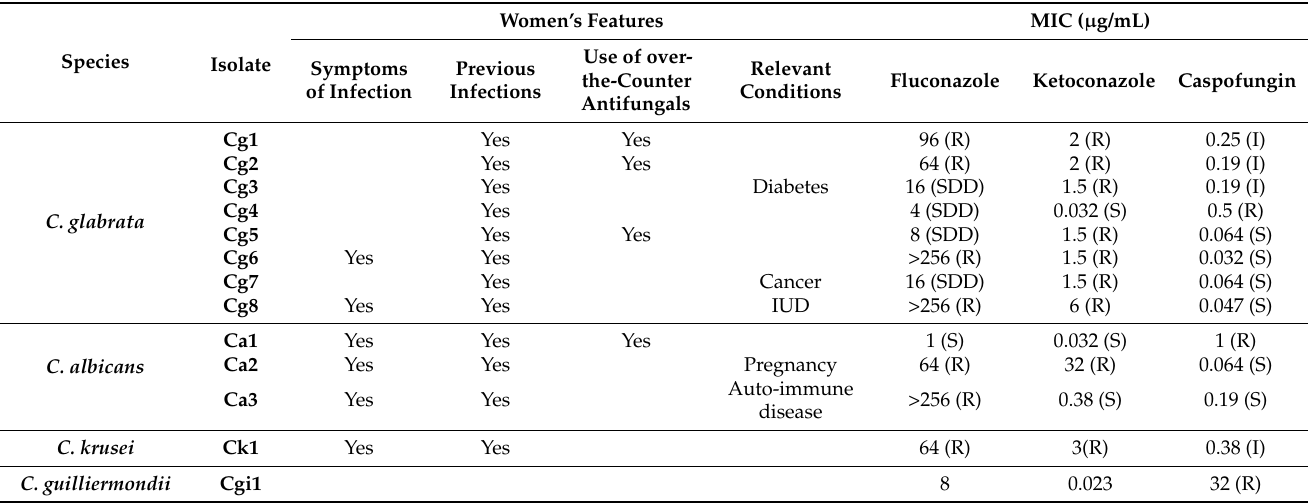
Table 1. List of vaginal isolates used in this study and respective data, including species, features of the women at the moment of sample collection, and minimum inhibitory concentration (MIC) of fluconazole, ketoconazole and caspofungin for each